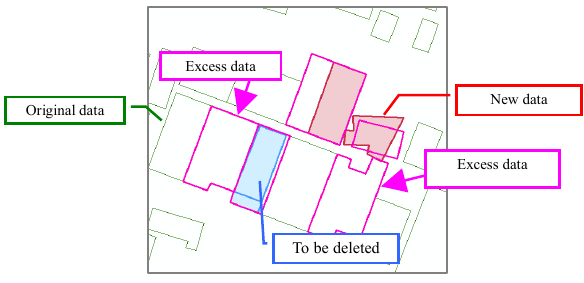
Figure 8. Example of excess data